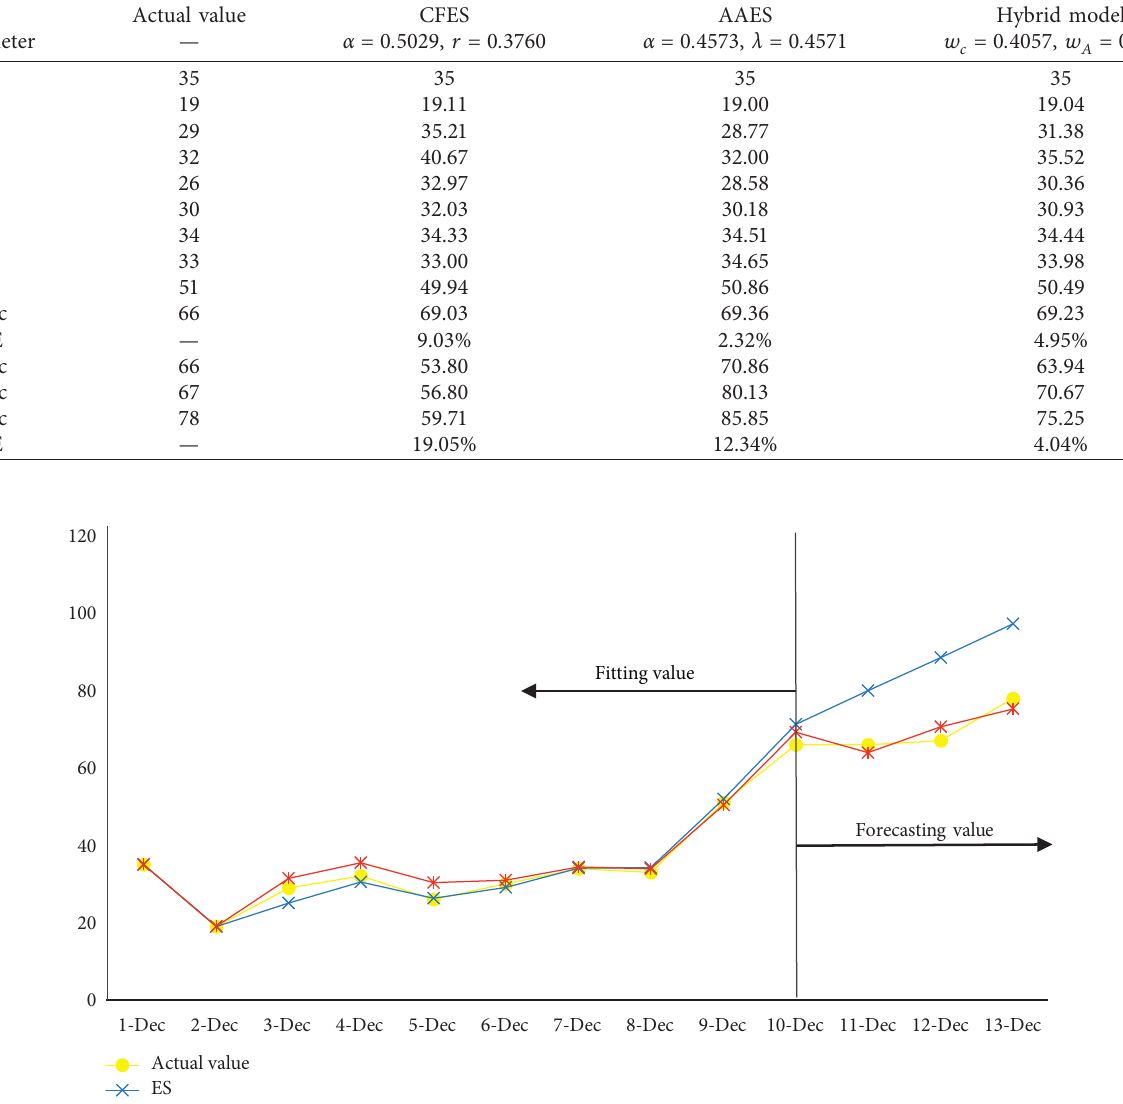
2.5 concentration.